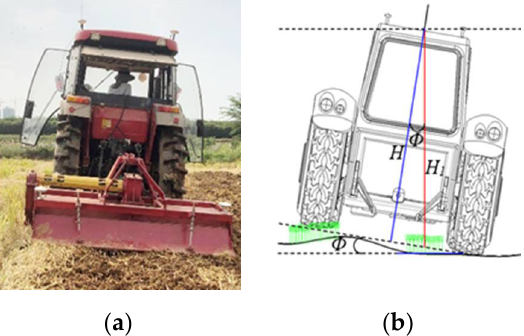
Figure 4. Height offset during operation. ( a ) Operation site; ( b ) Schematic of height offset. Note: H 1 is the height of the positioning antenna from the field surface, m; Ф is the roll angle of the GNSS heading antenna, (°); H is the actual height from the surface, m.